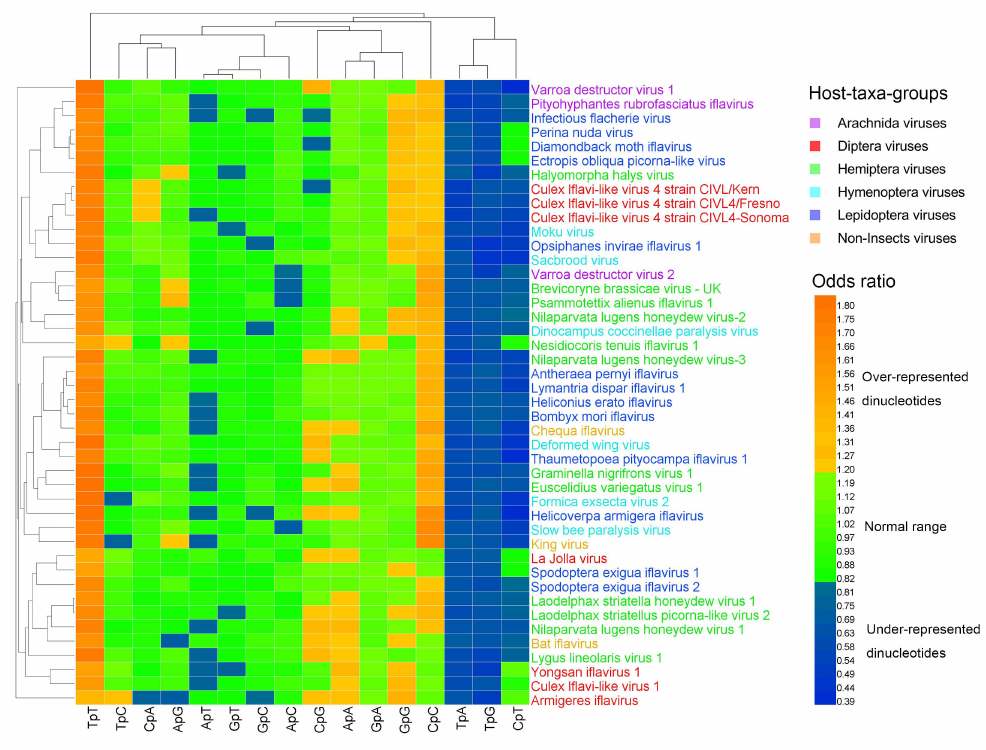
Figure 1. Heat map of the dinucleotide composition at the 1st–2nd codon positions. Iflavirus genomes were clustered independently of viral host taxa, implying that there exist other factors behind dinucleotide composition. The viruses and dinucleotides were clustered by the Average Linkage method using the Euclidean